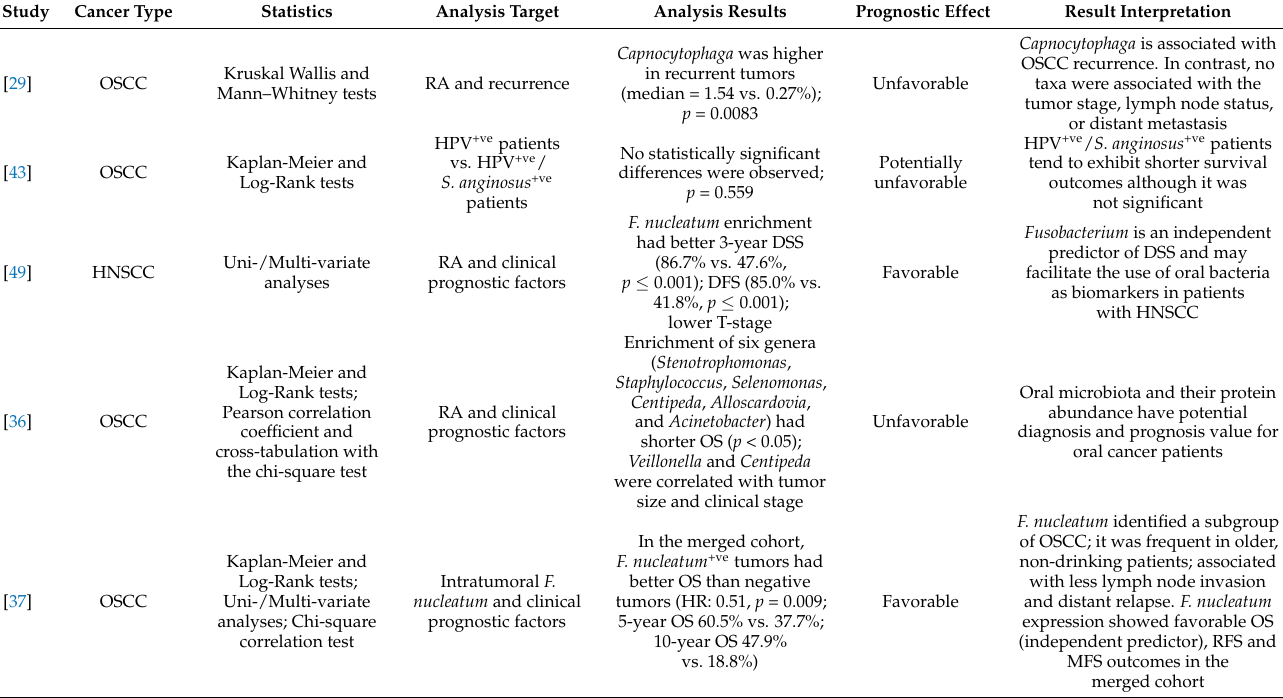
Table 3. The prognostic value of oral microbiota in head and neck squamous cell